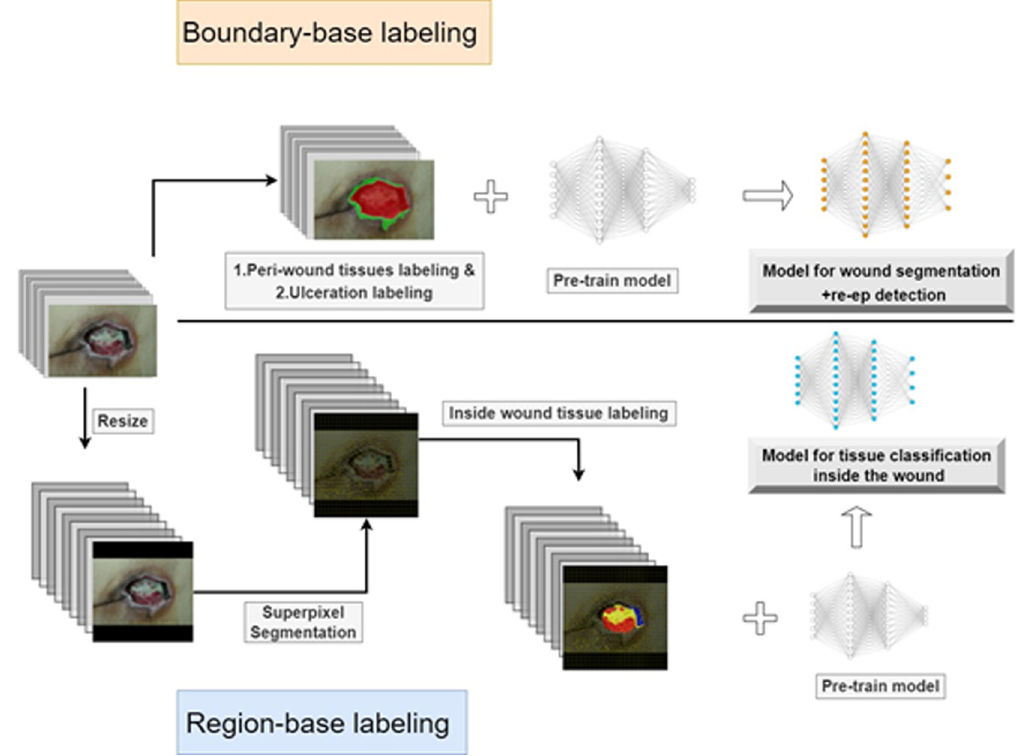
Fig 4. The workflow of labeling and training. Boundary-based labeling was used for peri-wound tissue and ulceration. Region-based labeling was applied for inside wound tissues.